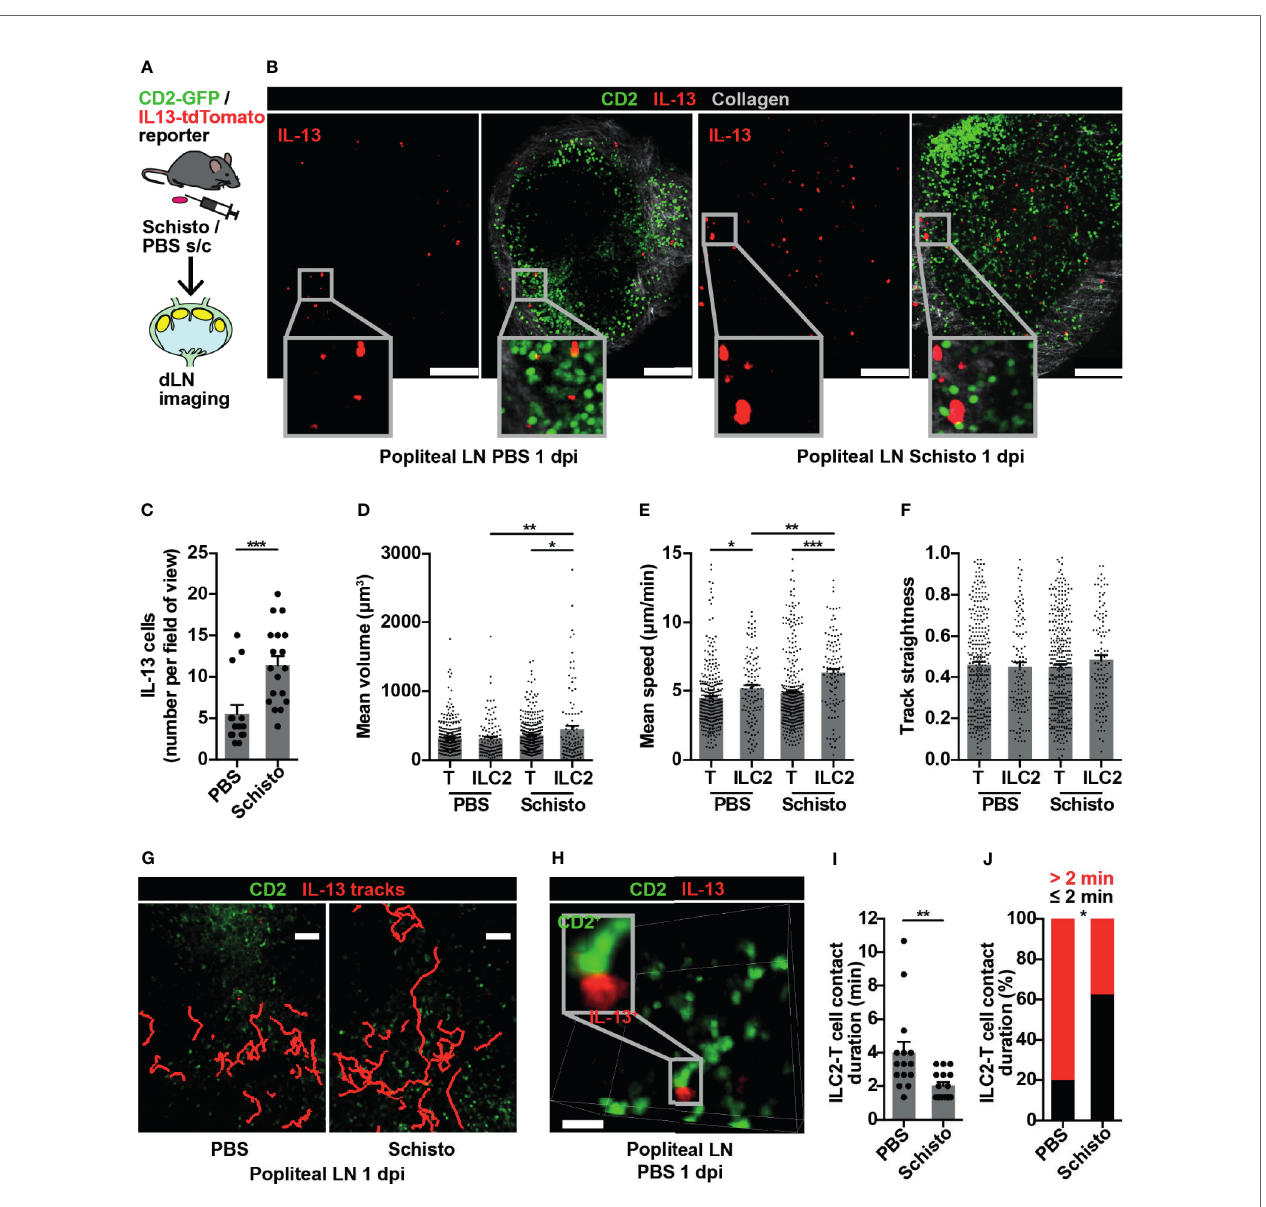
FIGURE 4 | ILC2s are present in popliteal LN and show dynamic changes in type 2 in fl ammation. (A) Schematic of experimental setup. (B) Stitched images of popliteal LNs 1 day post immunisation (dpi) with PBS or S. mansoni (Schisto) eggs; scale bar 150 µm, Z 40 µm. (C) Quanti fi cation of ILC2 numbers per fi eld of view; *** p < 0.001. Pooled data from 5-6 movies from 4 mice per condition, each dot representing one fi eld of view. (D – F) Quanti fi cation of (D) mean cell volume, (E) mean speed and (F) track straightness of popliteal LN ILC2s and T cells 1 dpi; * p < 0.05, ** p < 0.01, *** p < 0.001. Pooled data from 6 movies from 4 mice per condition, each dot representing one cell track. (G) Intravital image of ILC2 cell tracks in popliteal LN 1 dpi; scale bar 50 µm, Z 40 µm. (H) Intravital example of ILC2-T cell interaction in PBS-treated popliteal LN; scale bar 20 µm, Z 30 µm. (I) Quanti fi cation of ILC2-T cell contact duration (min), each dot representing one interaction; ** p < 0.01. (J) Quanti fi cation of proportions of ILC2-T cell contacts > 2 or ≤ 2 minutes; * p < 0.05 by Fisher ’ s test. Pooled data from 6 movies from 4 mice per